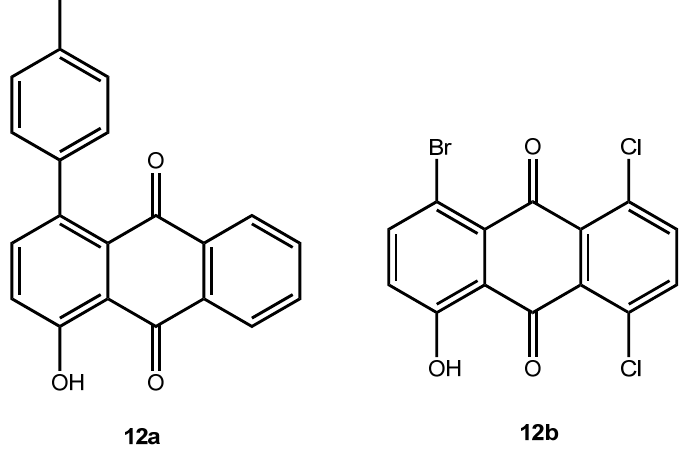
Figure 2. Hydroxyanthraquinones as side products in the oxidative cycloaddition reactions of thiophenes to quinines.